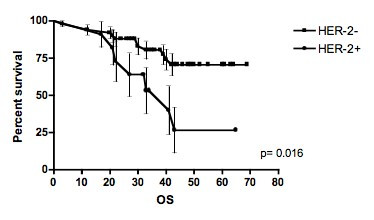
Kaplan-Meyer curve for OS in sixty patients subjected to neoadjuvant chemotherapy with docetaxel and epirubicin according to HER-2 protein expression.